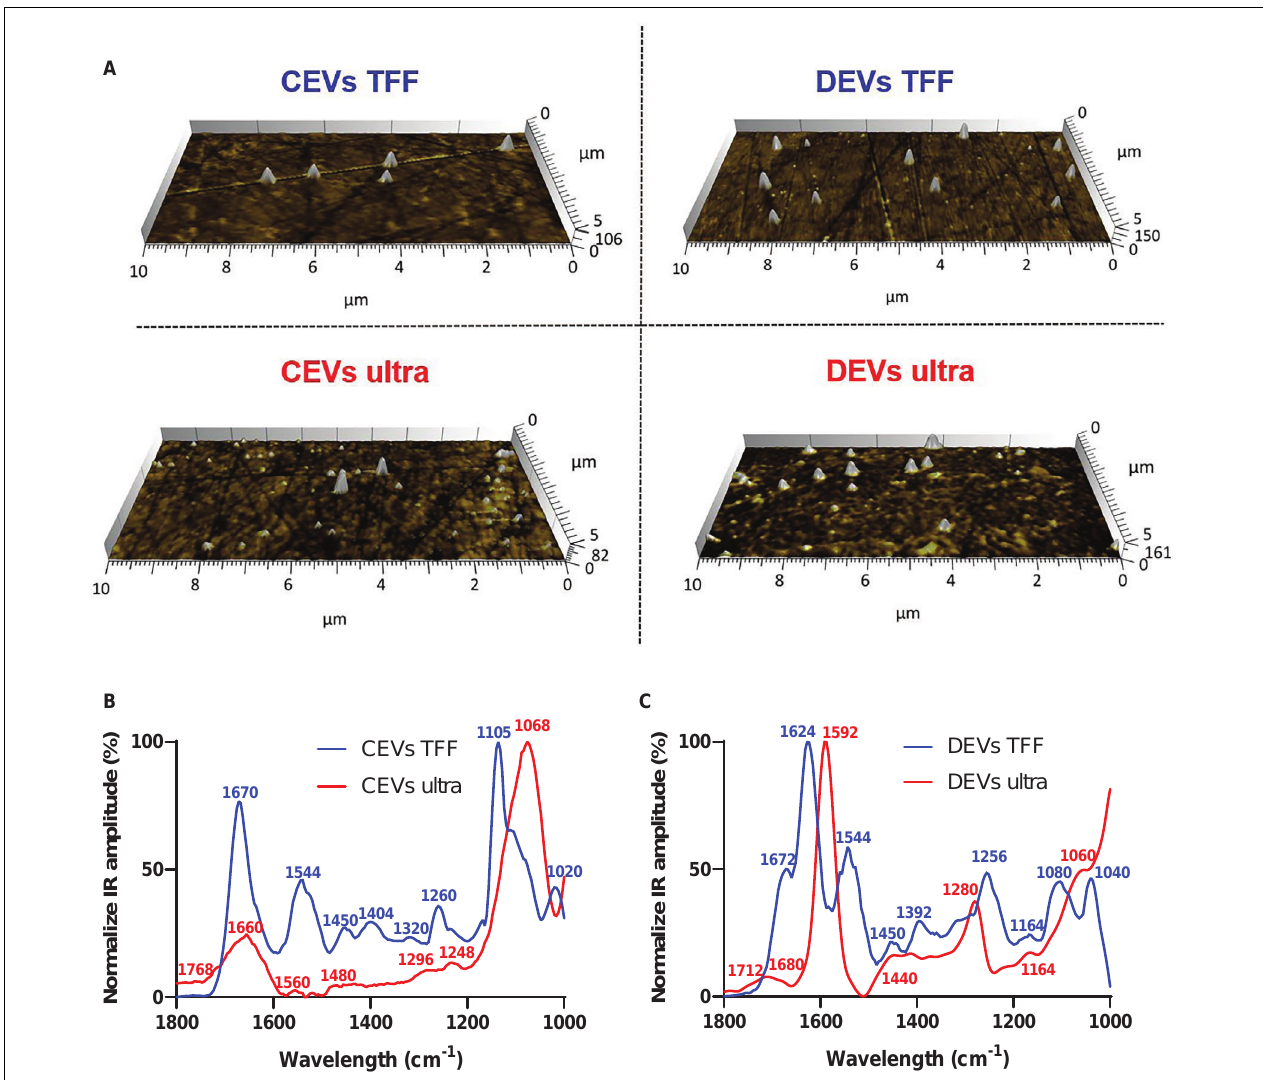
FIGURE 3 | Average infrared absorption spectra of extracellular vesicle (EV) molecular composition corresponding topographical atomic force microscopy (AFM) images for EVs. (A) AFM images (10 × 5 µ m) of individual EVs (indicated as white protrusions) deposited on prism. Normalization of the average AFM-IR spectra of (B) CEVs isolated using TFF and ultracentrifugation; (C) DEVs isolated using TFF and ultracentrifugation. At least 15 individual EVs were randomly selected and analyzed using Analysis StudioTM